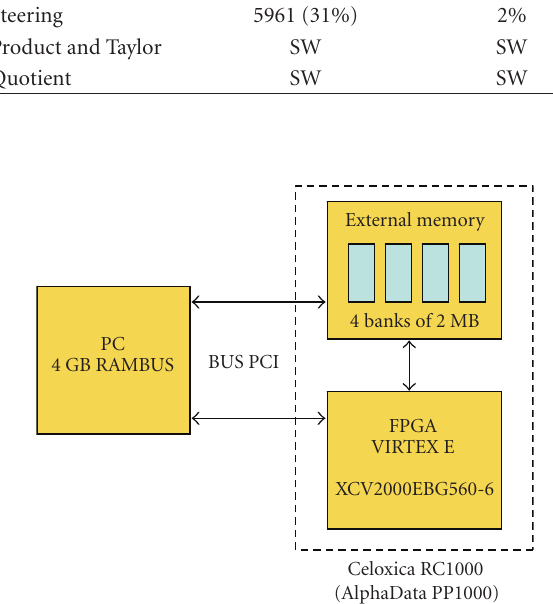
Figure 3: Scheme of the communication